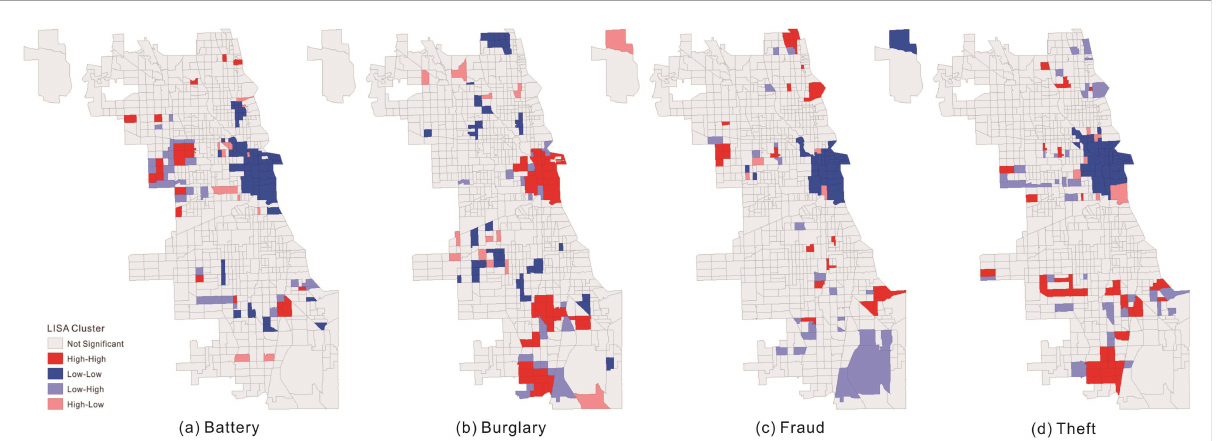
Figure 7. The local Moran’s I for theft, battery, burglary, and fraud. Dark red regions represent the high-high clusters, dark blue regions represent the low-low clusters, light blue regions represent the low-high spatial outliers, and light red regions represent the high-low spatial